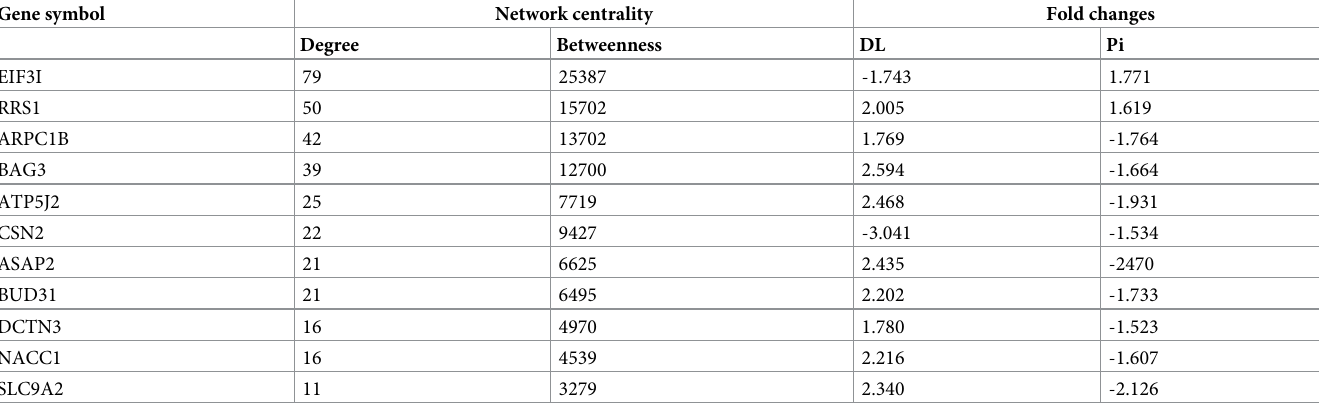
Table 1. Network centrality estimates and relative expression of major hub genes of transcriptome network shared between DL and Pi breeds. Gene symbol Network centrality Fold changes Degree Betweenness